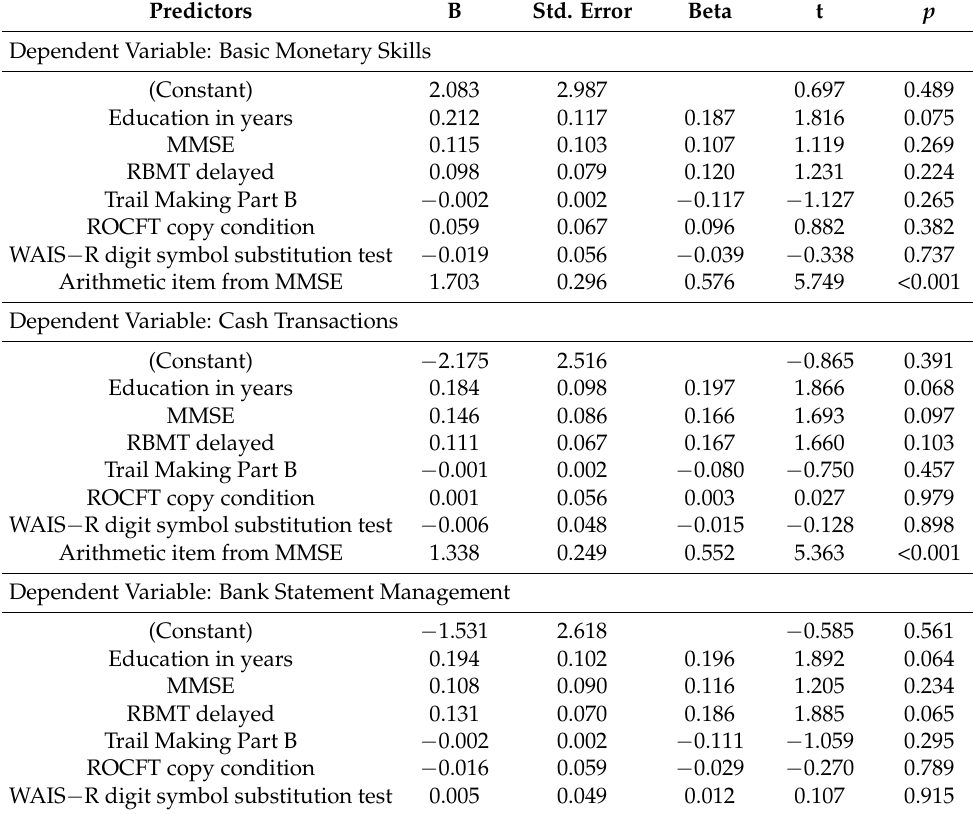
Table 4. Neuropsychological predictors for each subdomain of